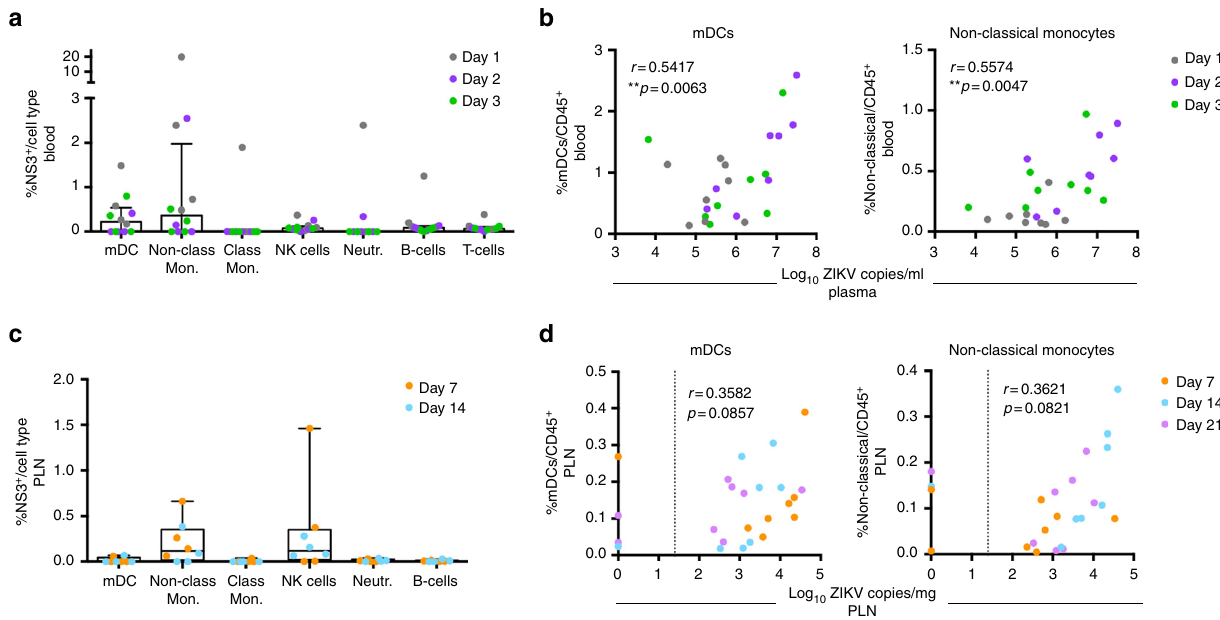
Fig. 4 Non-classical monocytes are the major in vivo cellular target of ZIKV infection. a , b ZIKV-infected cells isolated from blood or c , d PLN in the males were identi fi ed by fl ow cytometry following intracellular staining for ZIKV-NS3 and cell surface staining to identify immune cell subsets ( n = 4/timepoint). Positive cells were identi fi ed after background subtraction and adjusting for auto fl uorescence. The threshold limit was ≥ 100 cells/gate, and cell types that did not reach this threshold for all animals at all timepoints are excluded. a , c Percentages of NS3 + cells within myeloid DCs (mDCs), non-classical monocytes (Non-Class. Mon.), classical monocytes (Class. Mon.), NK cells, neutrophils (Neutr.), B cells, or T cells are shown 1, 2, and 3 dpi in blood and 7 and 14 dpi in the PLN. Dots are individual animals (males) with box plots showing the median with interquartile ranges. b Scatter plot and Spearman's correlation analysis of early (1 – 3 dpi) plasma viremia and frequencies of mDCs and non-classical monocytes in the blood at matched timepoints (1 – 3 dpi). d Correlation between viral load in the PLN and frequencies of mDCs and non-classical monocytes in the PLN at matched timepoints (7 – 21 dpi). Dotted line indicates the limit of viral RNA detection (25 copies per mg). b , d Spearman ’ s rank correlation coef fi cients are shown; signi fi cance of the unadjusted p -values are indicated as follows: ** p ≤